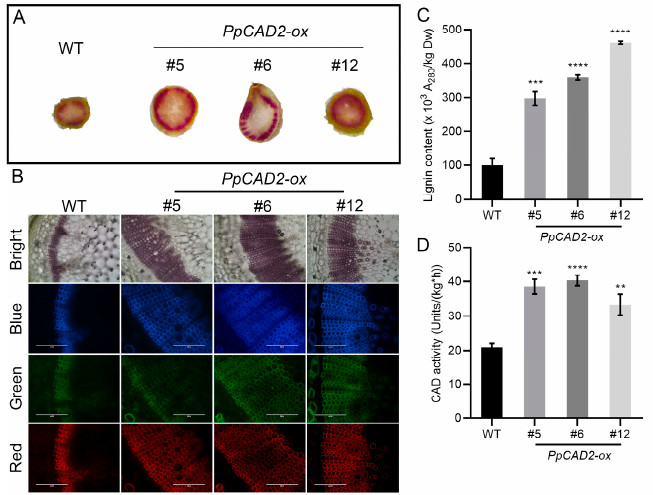
Figure 2. PpCAD2 increases the lignin content and the cinnamyl alcohol dehydrogenase (CAD) enzyme activity in the stem of transgenic tomato plants. ( A ) Transverse sections of the stem were stained with phloroglucinol–HCl for the detection of lignin; ( B ) Autofluorescence of the stem’s transverse slice. Bright: bright field images, Blue: blue autofluorescence, Green: green autofluorescence, Red: red autofluorescence. Scale bars = 200 µ m; ( C ) The lignin content of the stem in the WT and transgenic plants; ( D ) The CAD enzyme activity in the stem of WT and transgenic plants. In ( C ) and ( D ), the data represent the mean ± SD (standard deviation) from three biological replicates. Significant differences between the wild-type and transgenic plants are indicated (** P < 0.01, *** P < 0.001, **** P < 0.0001, Student’s t-test ).